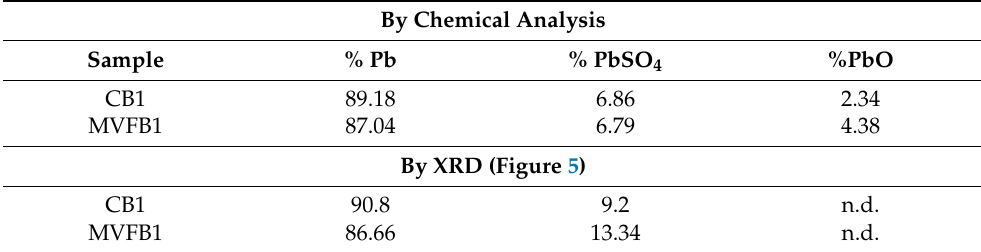
Table 8. Comparison of the chemical analysis by titration and XRD of the negative active materials after formation.